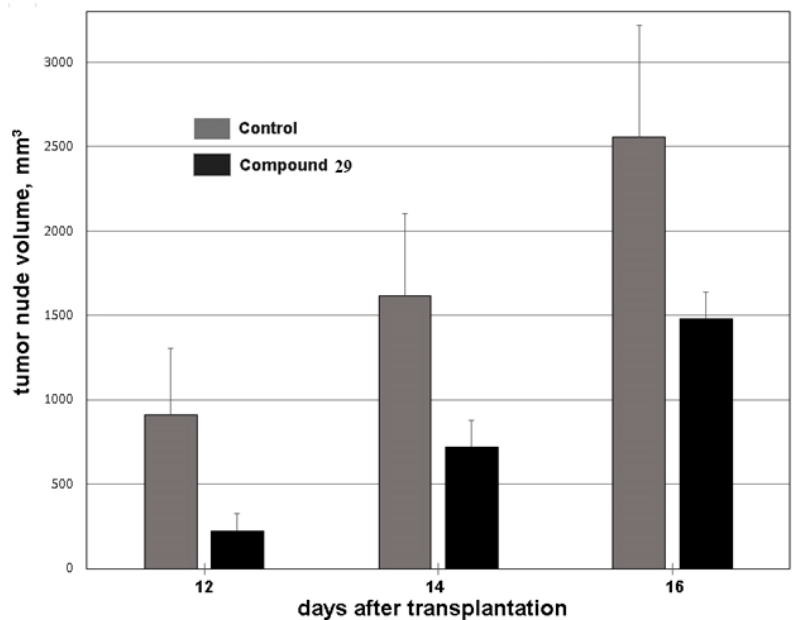
Figure 12. Changes in HCT116 tumor xenografts’ volume upon treatment with compound 29 (1000 mg/kg, o.d., 10 days, i.p.).